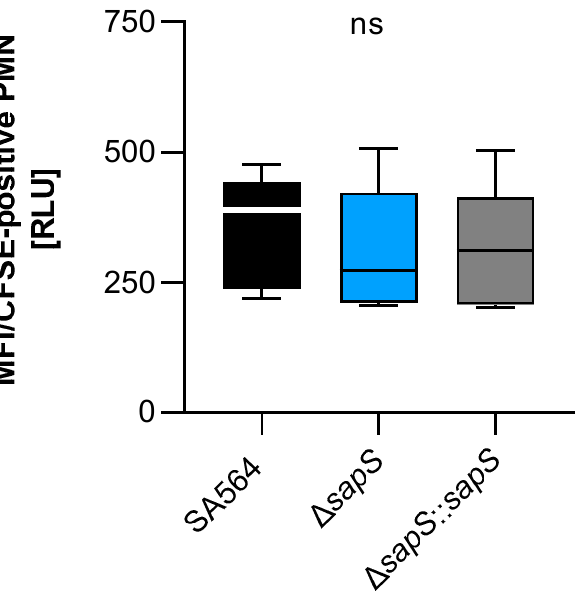
Figure 7. Impact of SapS on the phagocytosis of S.aureus strain SA564 by polymorphonuclear leukocytes (PMNs). The cells of S. aureus were labeled with carboxyfluorescein diacetate succinimidyl ester (CFSE) and mixed to lithium heparin-anticoagulated fresh human blood at a multiplicity of infection of 50 per PMN, and maintained at 37 °C and 1000 rpm. Using flow cytometry, as described in the Material and Methods section, the adhesion and ingestion of bacteria by PMNs was examined. The data show three biological replicates that were performed in triplicate. Data are presented as box and whisker plots showing the interquartile range (25–75%; box), median (horizontal line), and whiskers (bars; min/max). ns, not significant (Kruskal–Wallis test followed by Dunn’s post hoc test).